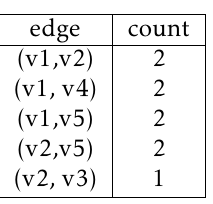
Table 4. Frequent Edges with count for Batch 1